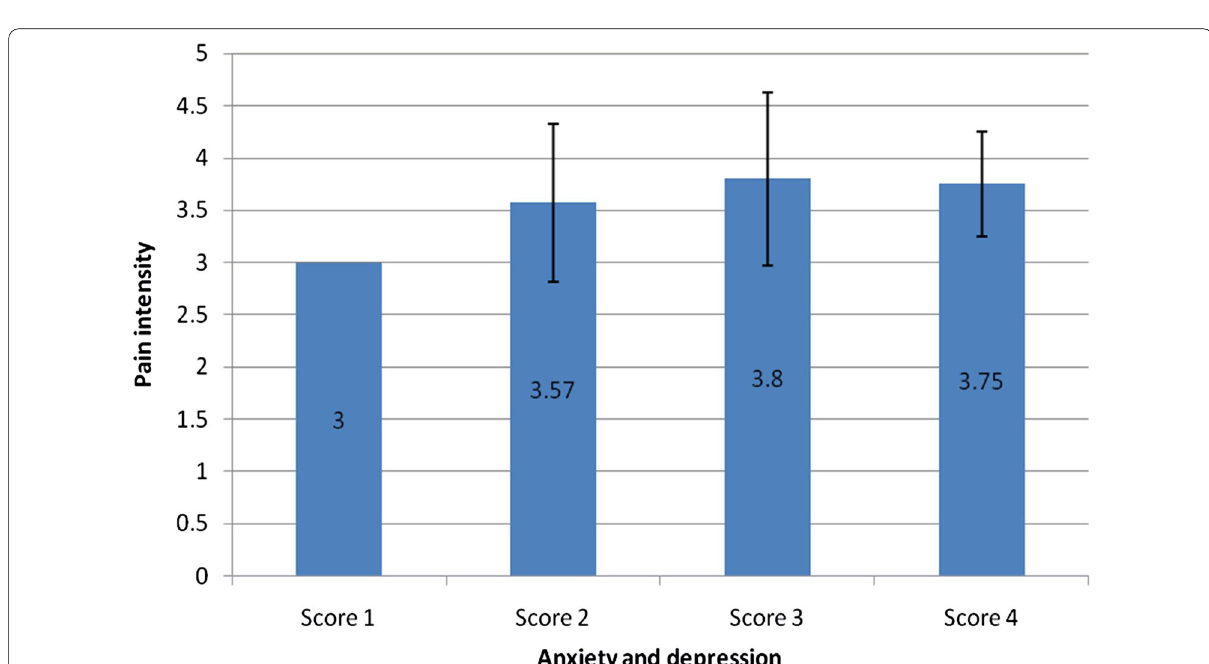
Fig. 3 Bar diagram showing the changes in mean value of anxiety and depression score of HRQoL and pain intensity in preoperative period and depicted the strong relationship between both the